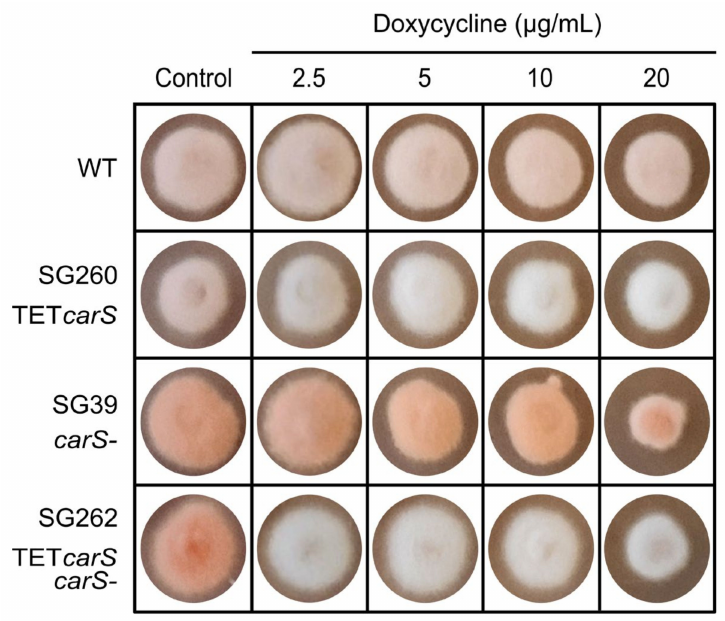
Figure 5. Growth and pigmentation of strains induced with a range of Dox concentrations. TET carS transformants (SG260 and SG262), the wild strain (WT) and carS mutant (SG39) were grown on minimal DG agar medium with different Dox concentrations (0, 2.5, 5, 10, and 20 µ g/mL) at 30 ◦ C, for five days under